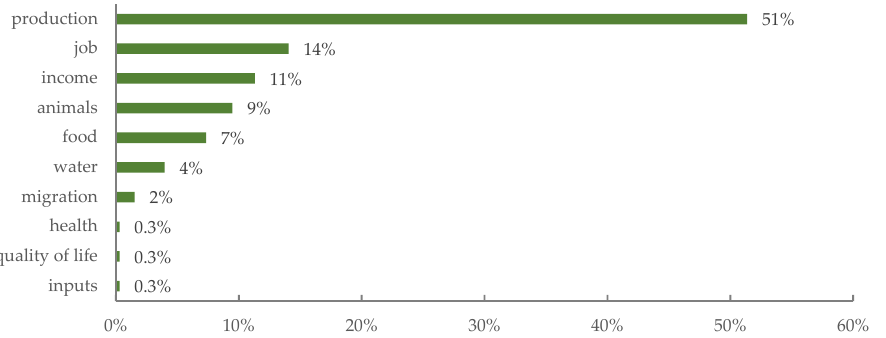
Figure 10. Perception of the main rural income impacts among the local farmers related to drought (Source: prepared by the authors).